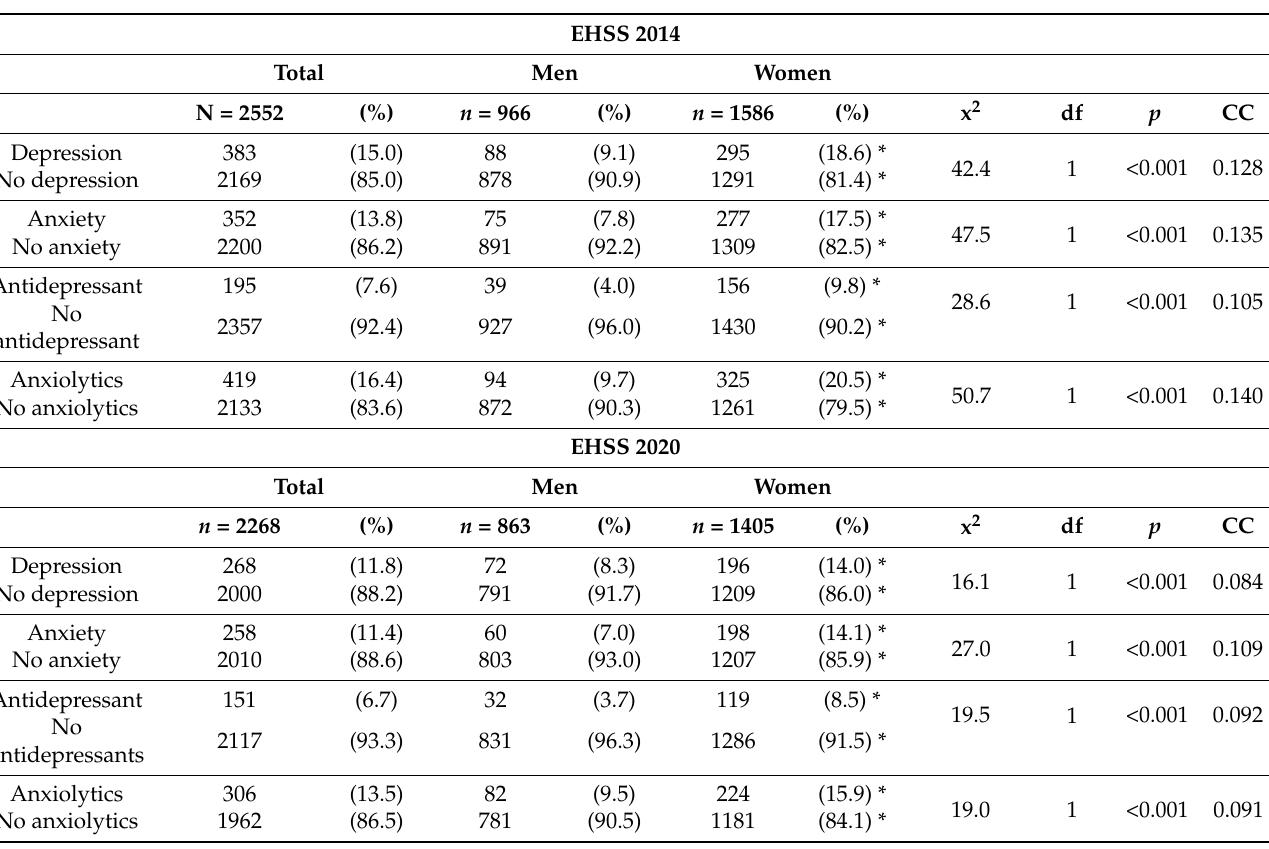
Table 1. Depression, anxiety, antidepressant use and anxiolytic use proportions in Spanish informal caregivers, as well as sex comparison